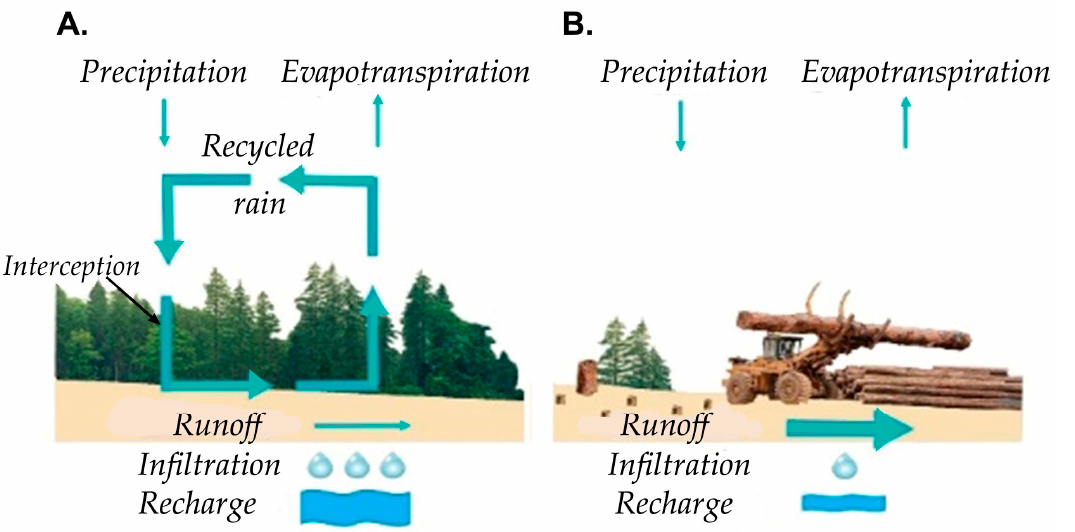
Figure 1. Schematic diagram showing ( A ) a natural forest and ( B ) the effects of deforestation on precipitation, runoff, infiltration, and recharge. (Figure by the authors).